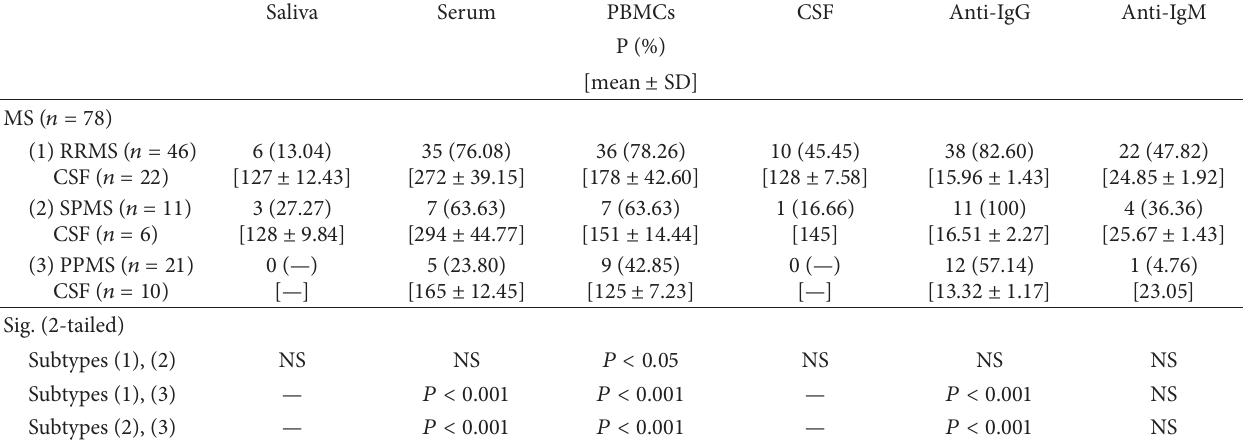
T 2: Prevalence of HHV-6-DNA (copies/mL) and HHV-6-antibodies (U/mL) among different subtypes of MS. HHV-6-DNA was analyzed in serum via qPCR as described previously. Concentration of plasma anti-HHV-6, IgG and IgM were measurement in an automated instrument, according to the manufacturer’s instructions. Data are representative of three independent